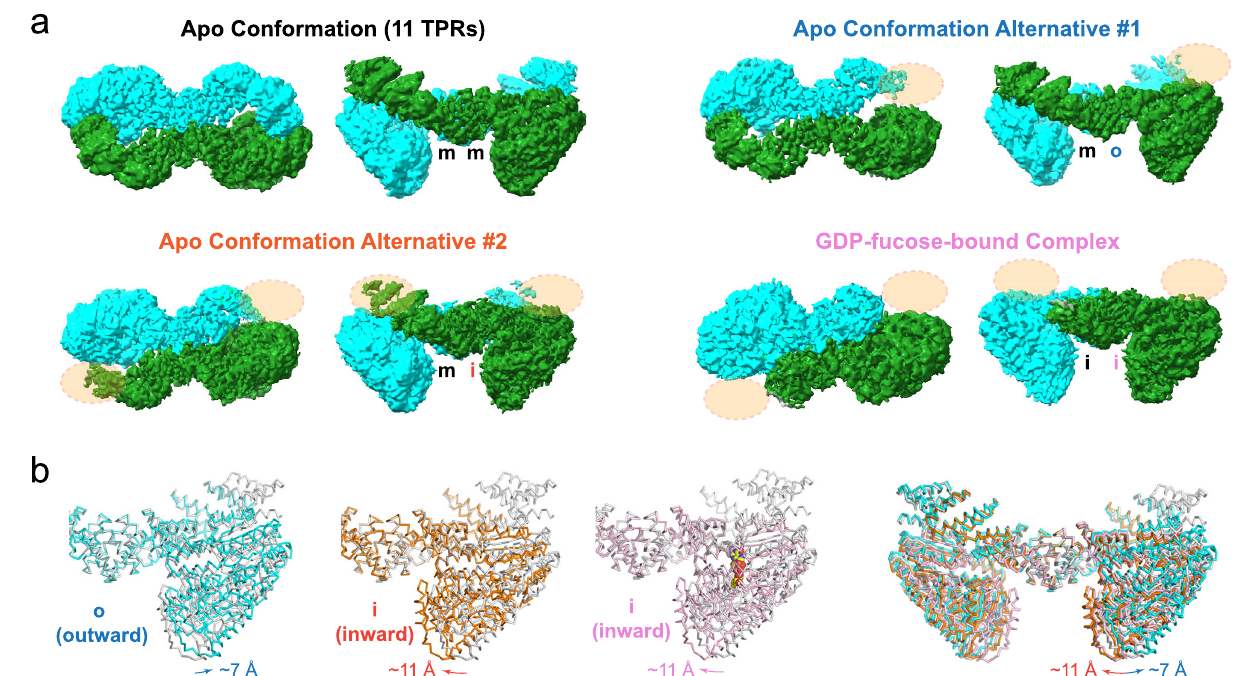
Fig. 3 | SPY samples multiple conformational states. a Cryo-EM maps reveals distinct conformations of SPY in the apo and GDP-fucose-bound states. Missing densities of the TPR region are indicated by peach-colored ovals. The three con- formations (outward ( “ o ” ), middle ( “ m ” ), and inward ( “ i ” )) of the catalytic domain are labeled following their relative position to the central TPRs. b Overlay of SPY